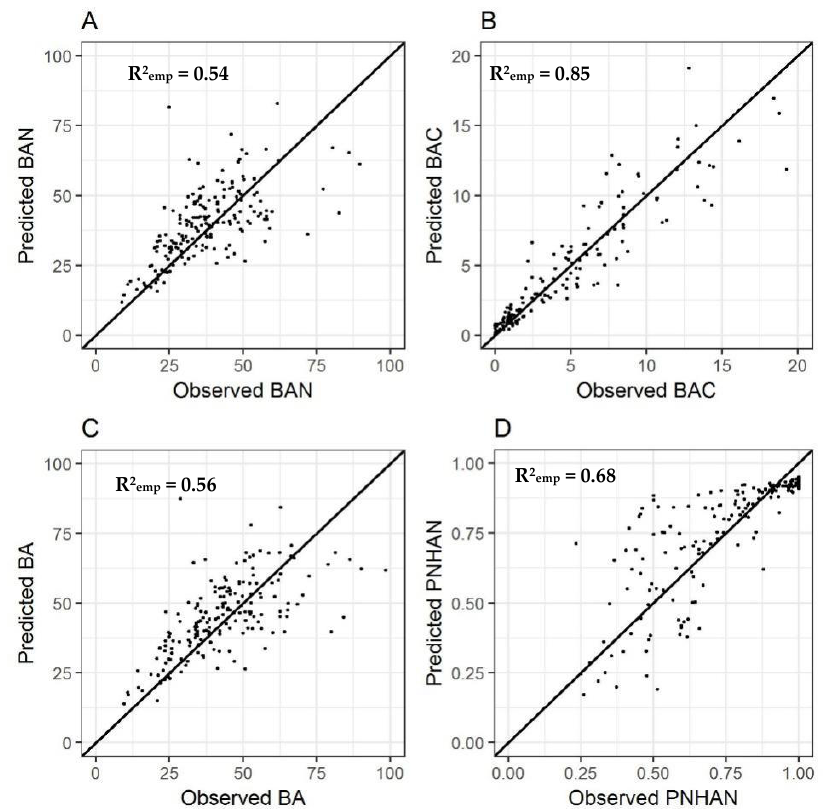
Figure 2. Observed vs. predicted values for ( A ) basal area of Nothofagus species (BAN, Equation (7)); ( B ) basal area of companion species (BAC, Equation (8)); ( C ) total basal area, BA = BAN + BAC; and ( D ) the proportion of number of trees per hectare of Nothofagus species (PNHA, Equation (3)). All panels are from the Temporary Plot series (TP1 and TP2).